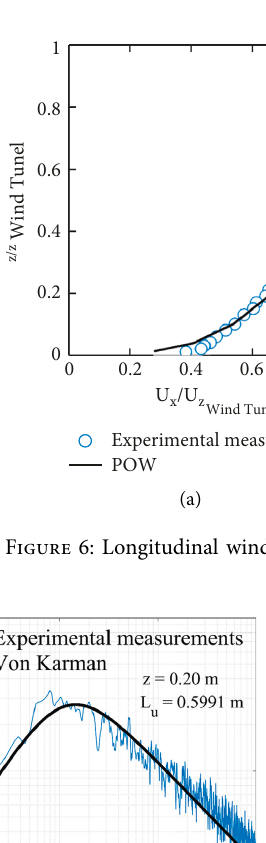
Figure 5: Wind tunnel set-up and passive turbulence generator.